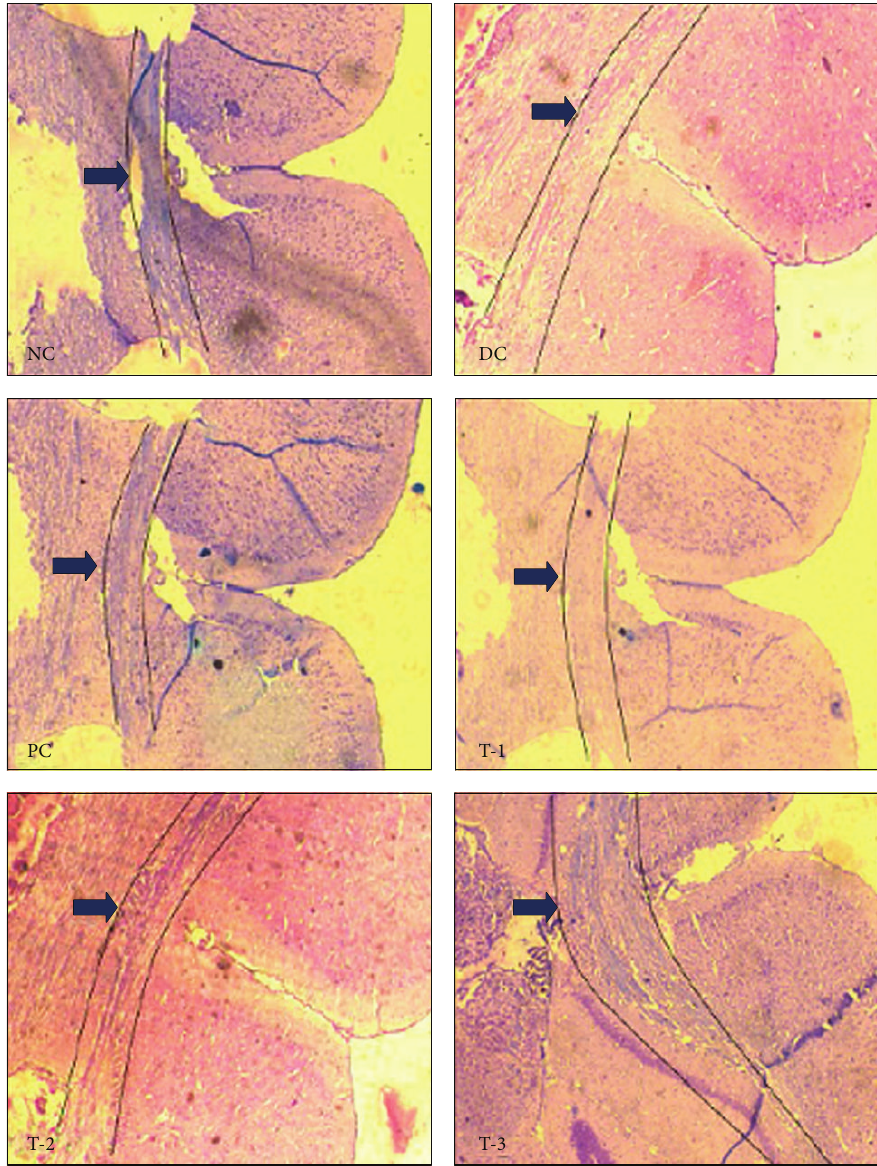
Figure 3: Luxol fast blue stained coronal sections of C57BL/6 mice brains observed under 40x magnification. The region of corpus callosum is highlighted and indicated by the arrow. Blue colour indicates presence of myelin. (NC: normal control; DC: disease control; PC: positive control; T-1: diazepam treatment; T-2: phenobarbitone sodium treatment; T-3: sodium valproate